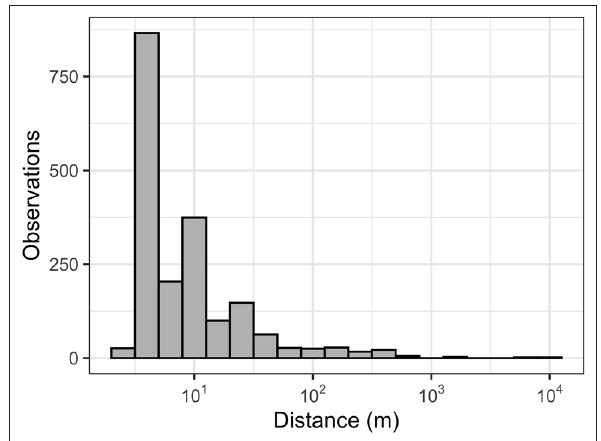
Figure 8 Location uncertainty in meters associated with each observation as provided from iNaturalist data. The mode and median positional accuracy were 5 m and 6 m, respectively, and the mean was 41 m. There is a very long tail of observations, up to 10 km, on this